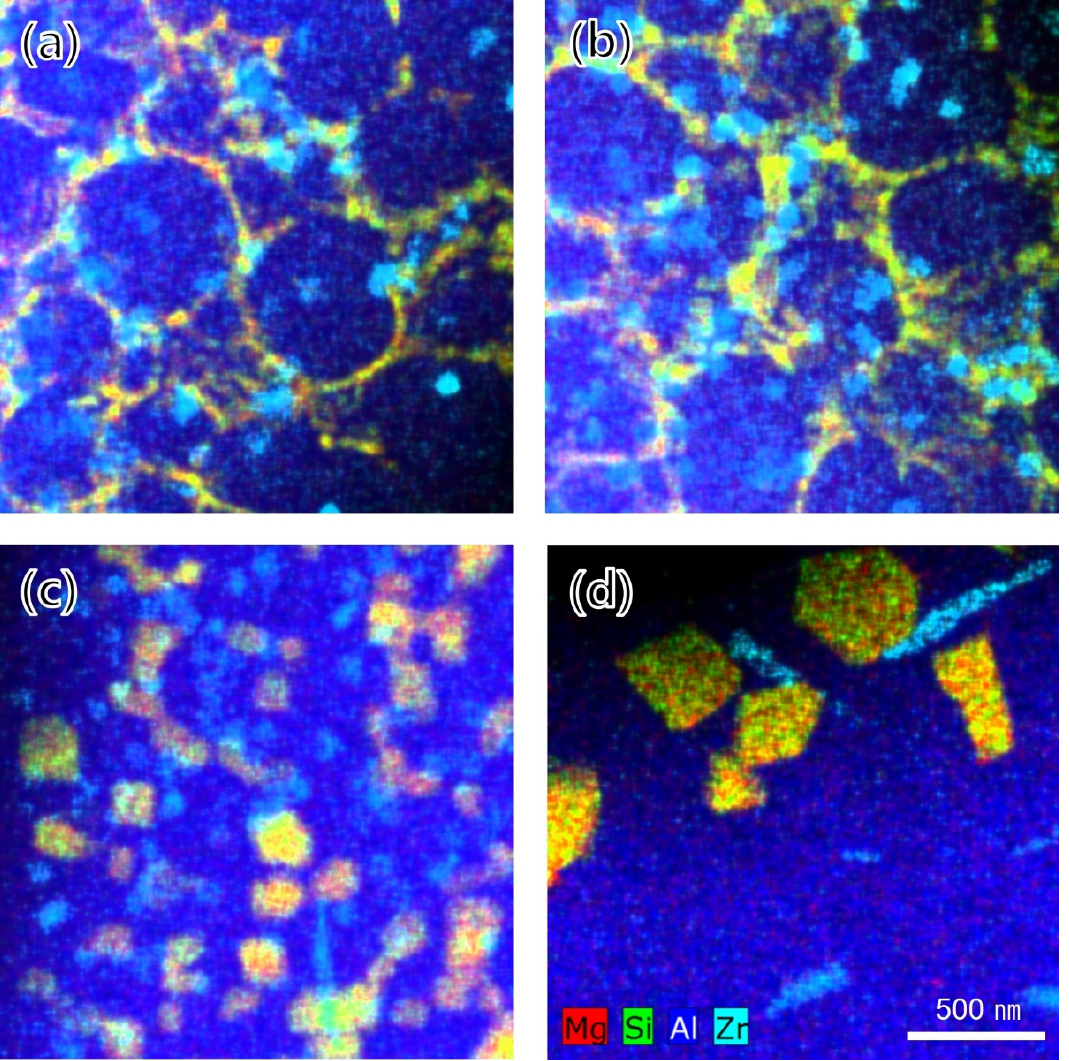
Figure 10. TEM-EDS chemical maps in the fine-grain region: ( a ) as-built, ( b ) HT1, ( c ) HT2, and ( d ) HT3 conditions.